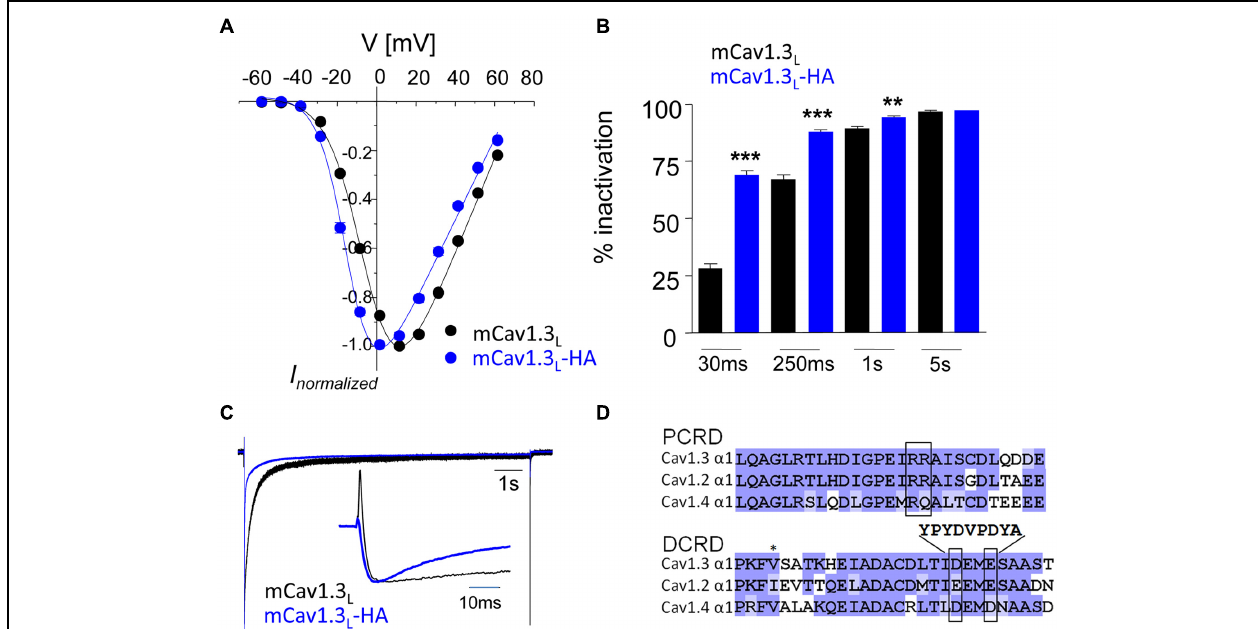
FIGURE 1 | Activation and inactivation properties of I Ca through